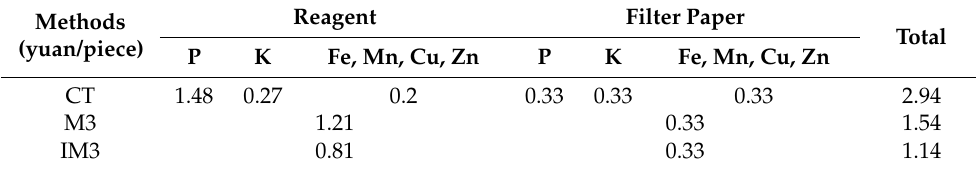
Table 4. The comparison of testing price among three test